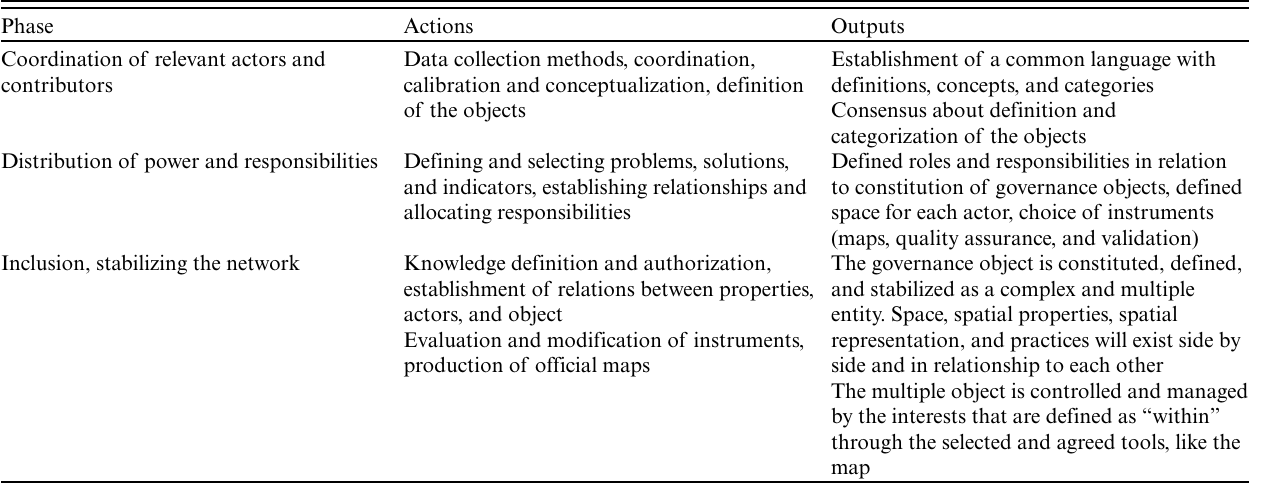
Table 1 . Overview of the phases for creation of a governance object (after Mol